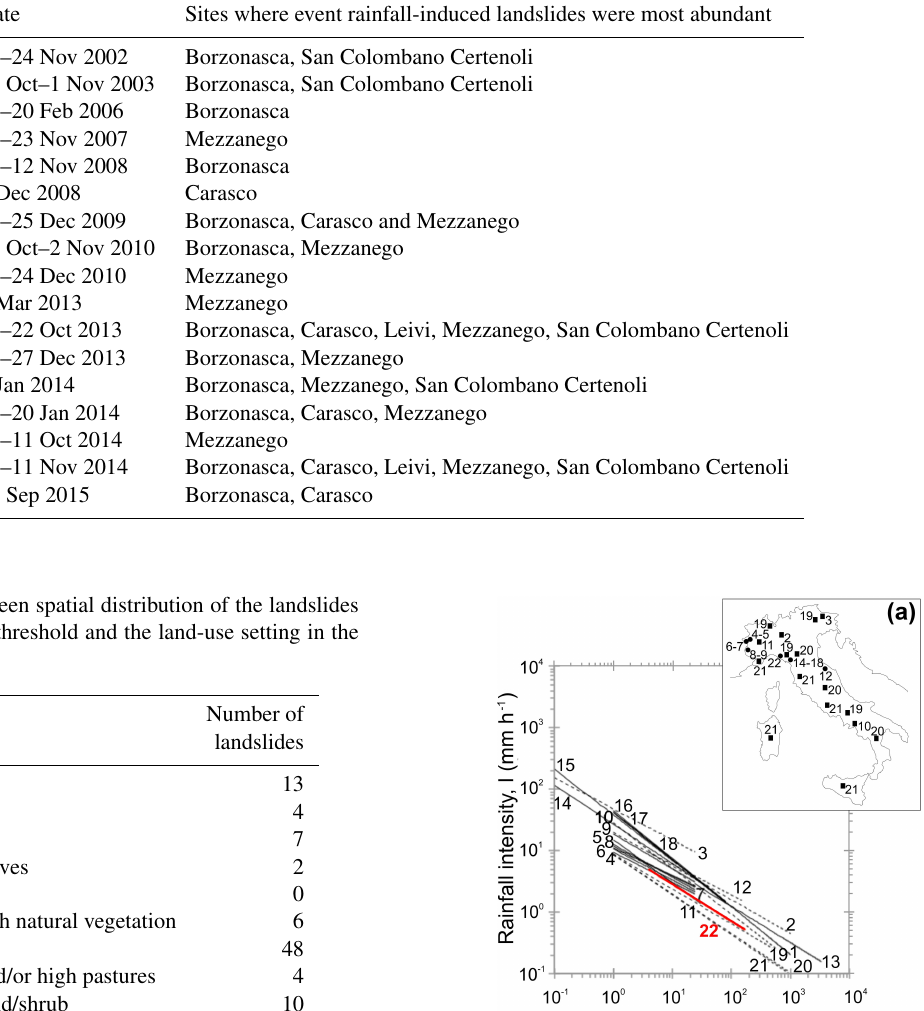
Table 4. Rainfall events that have triggered – mostly shallow – landslides in the central sector of the Entella catchment, from November 2002 to September 2015.